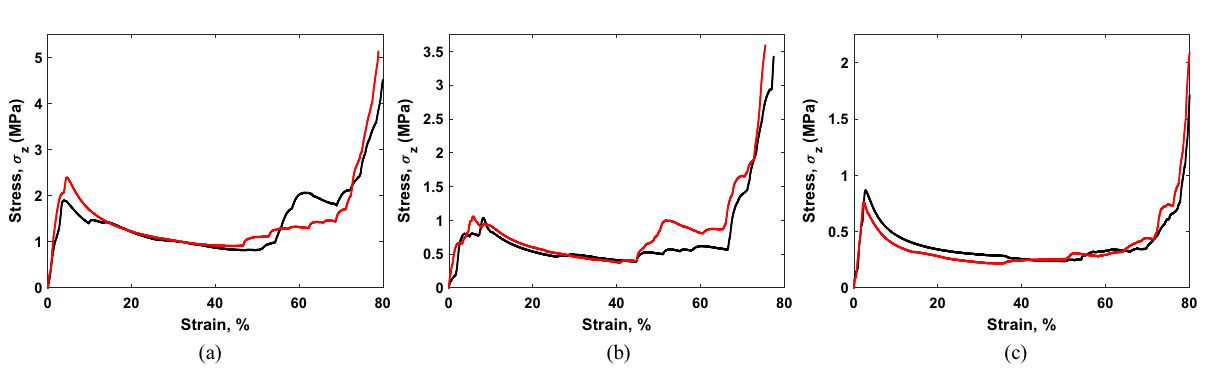
Figure 7. Stress vs lattice strain curves of 2 × 2 × 2 cell lattice structures for Z -axis loading: ( a ) 8 mm cell, relative density = 0.068; ( b ) 10 mm cell, relative density = 0.053; and ( c ) 12 mm cell, relative density =